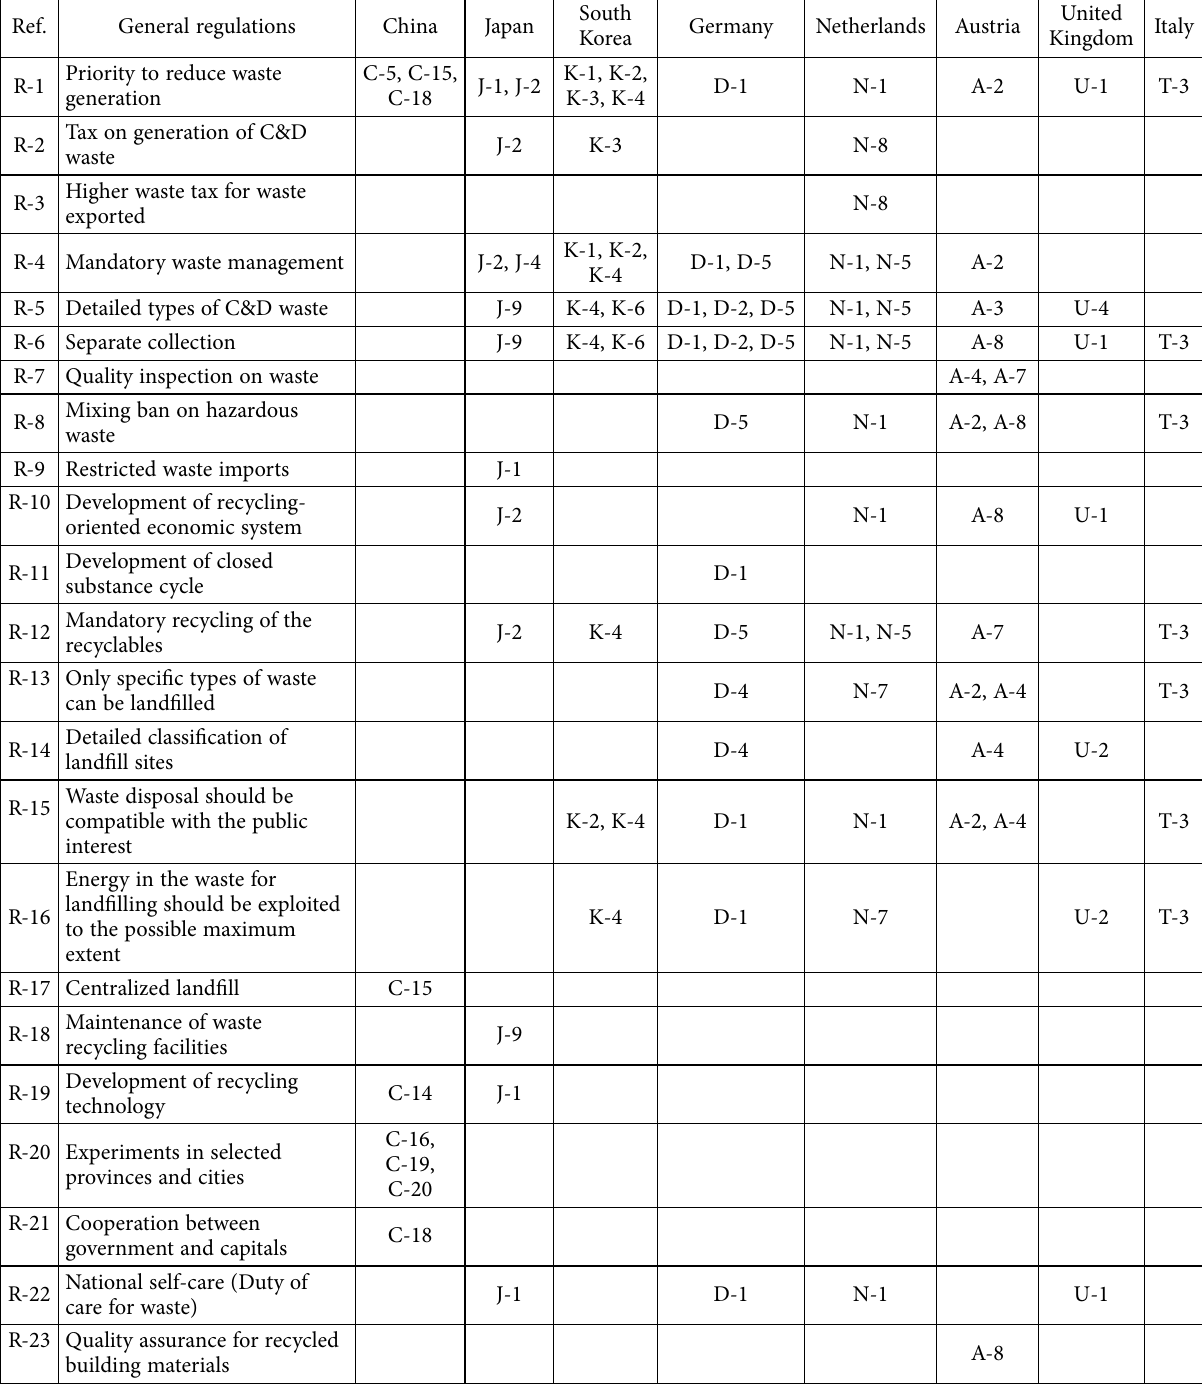
Table 11. Comparison on general regulations